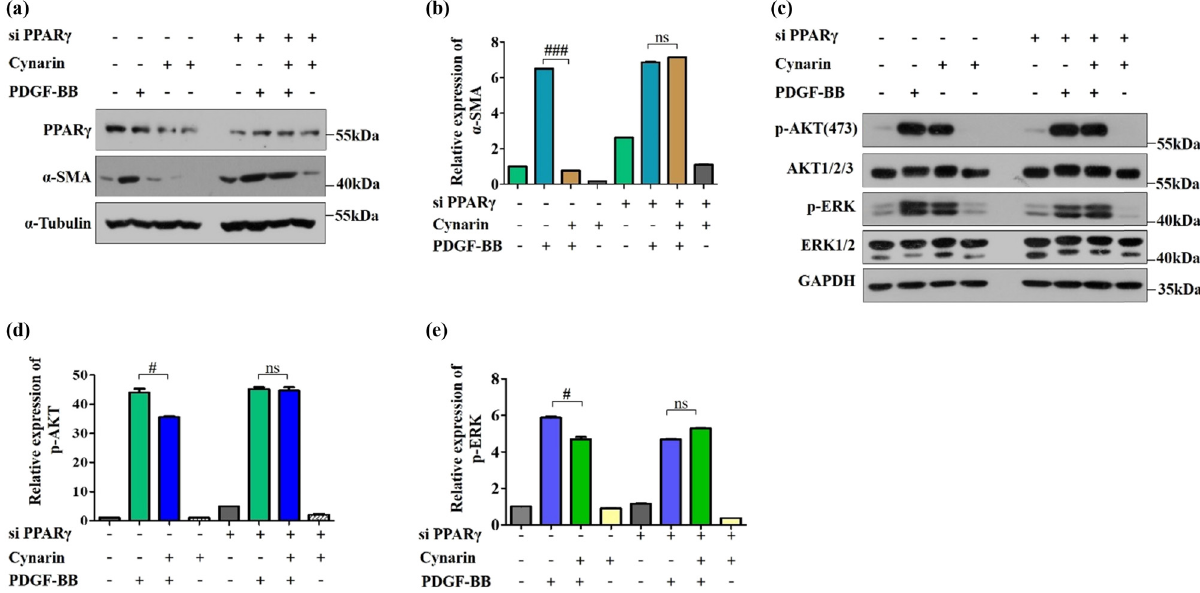
Figure 5: The inhibition of HSC activation by cynarin is dependent on PPAR γ . ( a and b ) Knockdown of PPAR γ abolished the inhibitory e ff ect of cynarin on PDGF - BB - induced α - SMA expression. ( c – e ) Knockdown of PPAR γ abolished the inhibitory e ff ect of cynarin on PDGF - BB - induced